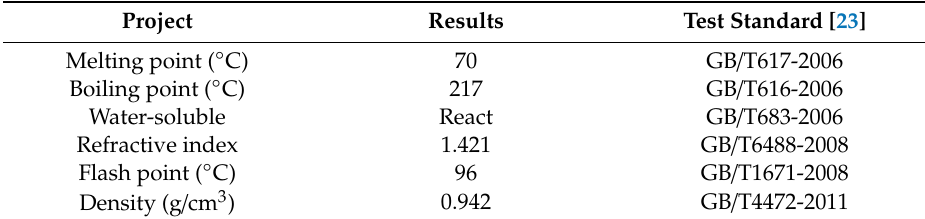
Table 4. Silane coupling agent technical indicators.